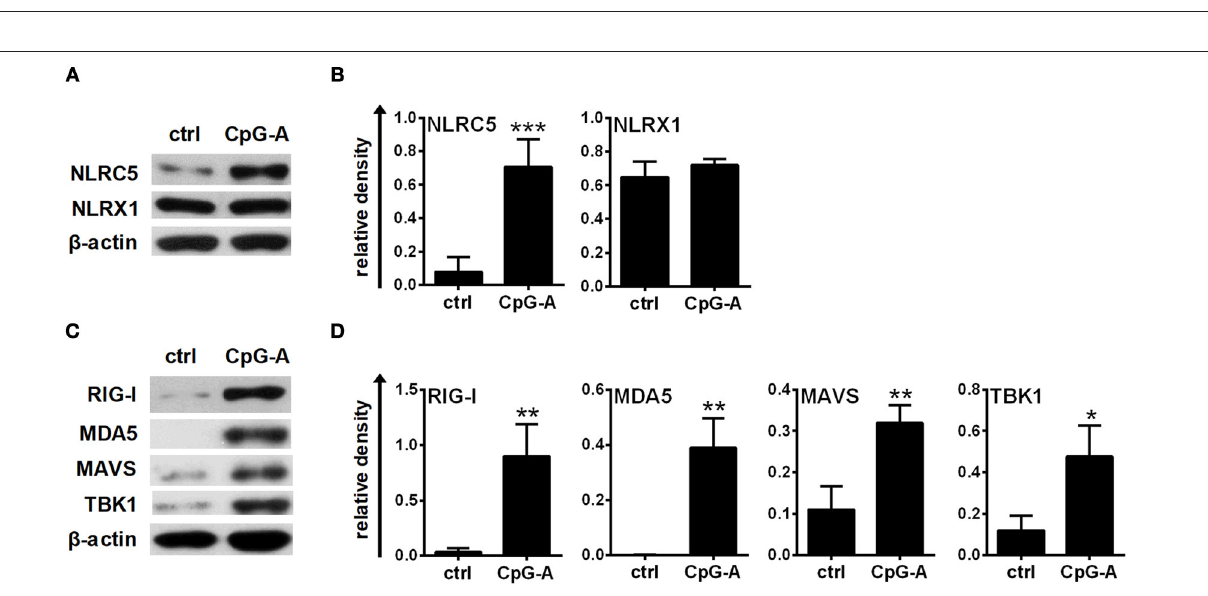
FIGURE 1 | mRNA level by Q-PCR (A) and at the protein level by western blotting (B,C) . The changes in protein levels of RIG-I, MDA5, MAVS, and TBK1 were also analyzed after CpG-A treatments by western blotting (D,E) . Representative blots are shown in (B,D) . Data are shown as mean ± SD from 4 to 6 independent experiments in panels (A,C,E) . Data were analyzed using one-way ANOVA followed by Bonferroni’s post-hoc test. * p < 0.05, ** p < 0.01, *** p < 0.001, **** p < 0.0001 1 µ M CpG-A vs control; + p < 0.05, ++ p < 0.01, +++ p < 0.001, ++++ p < 0.0001 0.5 µ M CpG-A vs control; # p < 0.05, ## p < 0.01, ### p < 0.001, #### p